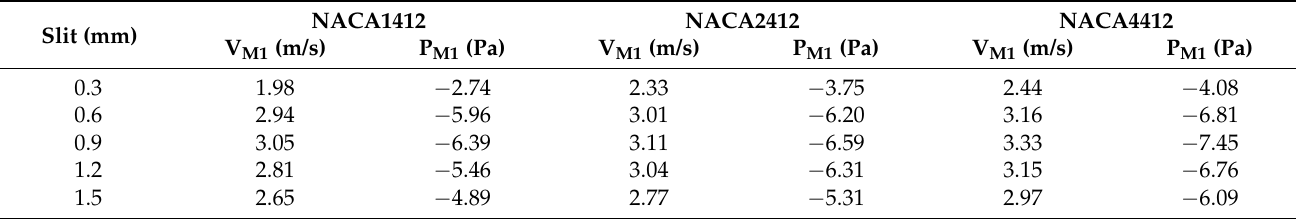
Table 1. Velocity and pressure of airflow induced on Plane M1 by all of the airfoils, with fixed airfoil thickness and varying airfoil cambers and outlet slit sizes. Slit